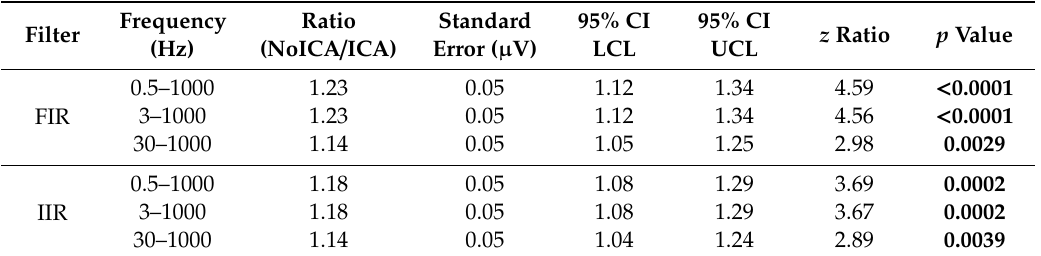
Table 6. Estimated contrasts of ICA (ICA / No ICA). Significant e ff ects ( p < 0.05) are in bold